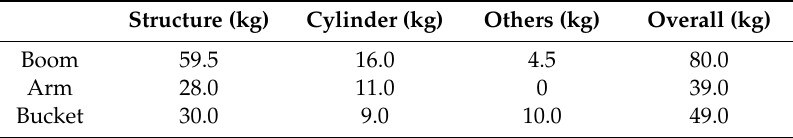
Table 2. The weight distribution of the front